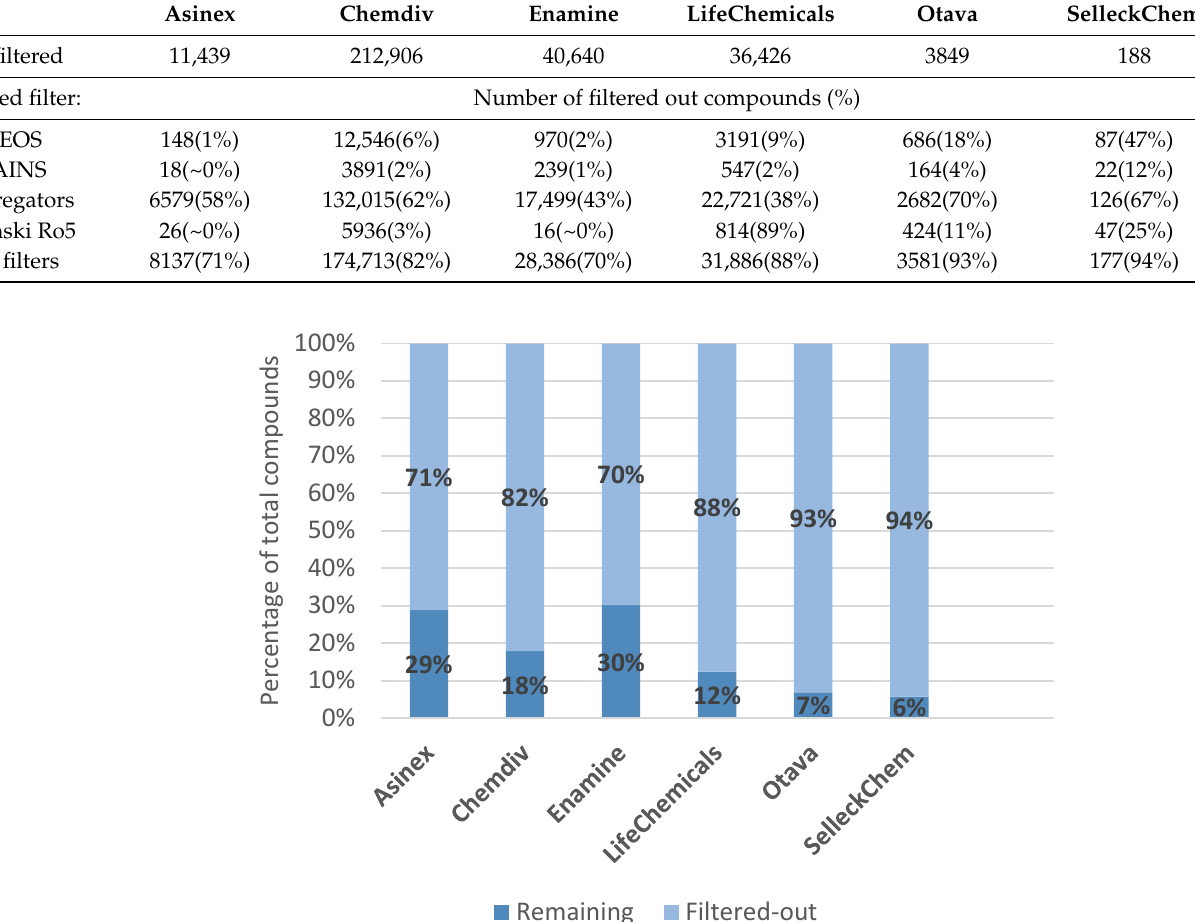
Figure 10. Compound (relative) retention after post-filtering for REOS, PAINS, Aggregators and the Lipinski rule of 5 (one rule break allowed) on protein–protein-interaction-inhibitor-targeted libraries.